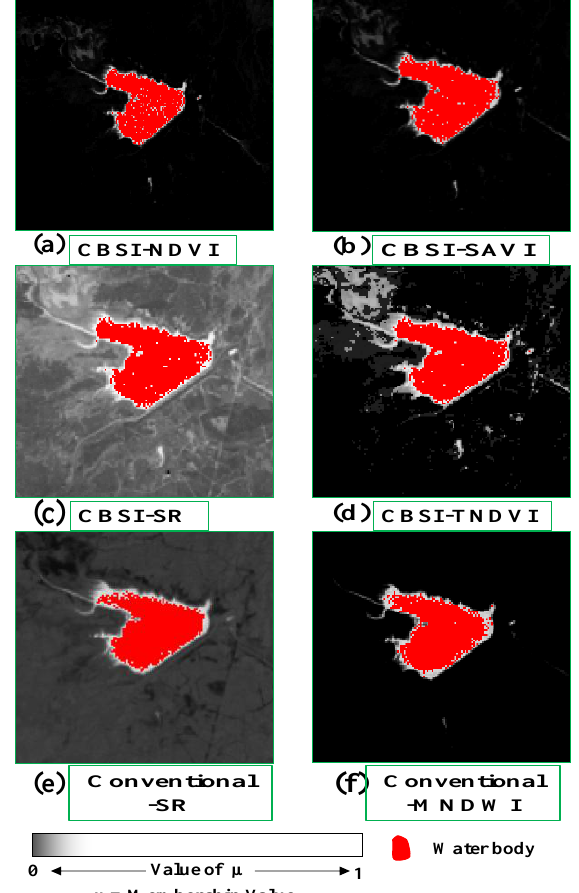
Figure 3.Different classified output for